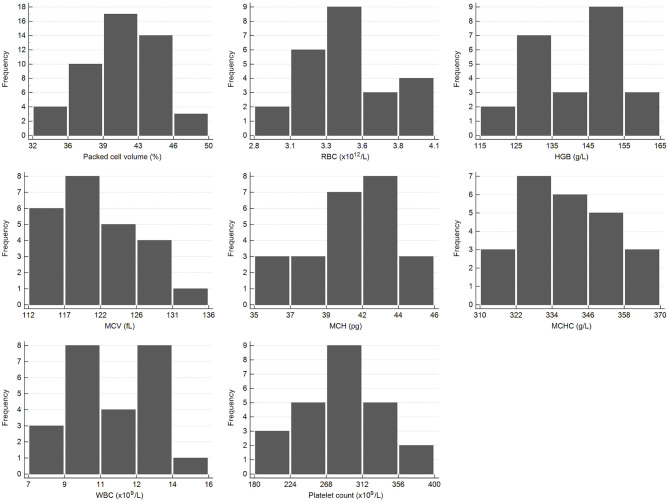
Histograms showing the distribution of results for selected hematology measurands from the African elephant (Loxodonta africana) for the scil Vet abc or Horiba ABX Micro ESV60. The x-axis represents the measurand result; the y-axis represents the frequency of these values occurring.